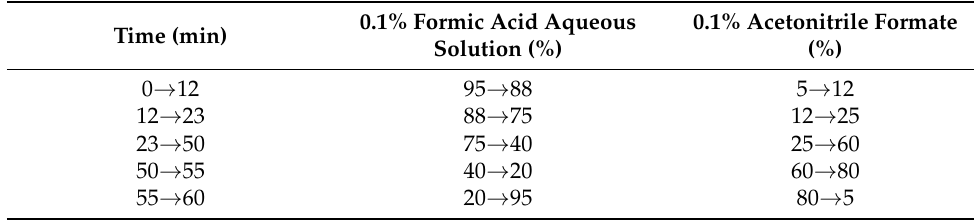
Table 9. UPLC-QTOF-MS/MS gradient elution